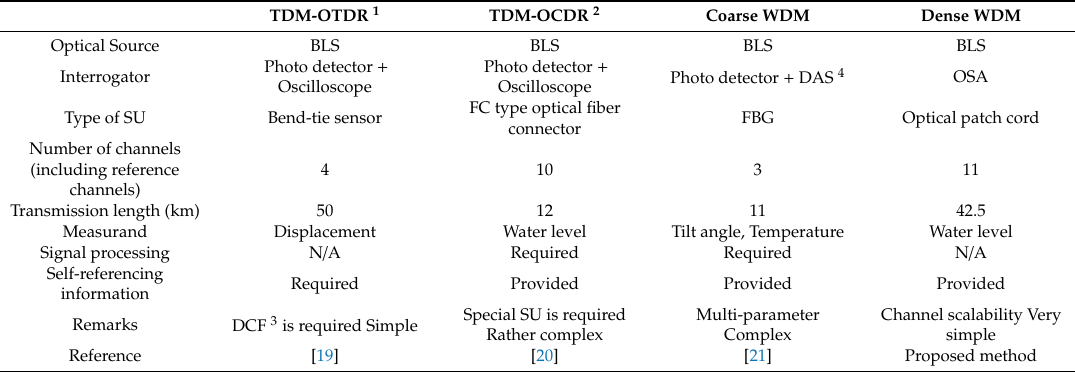
Table 1. Comparison of the various passive optical fiber sensor networks based on Broadband Light Source